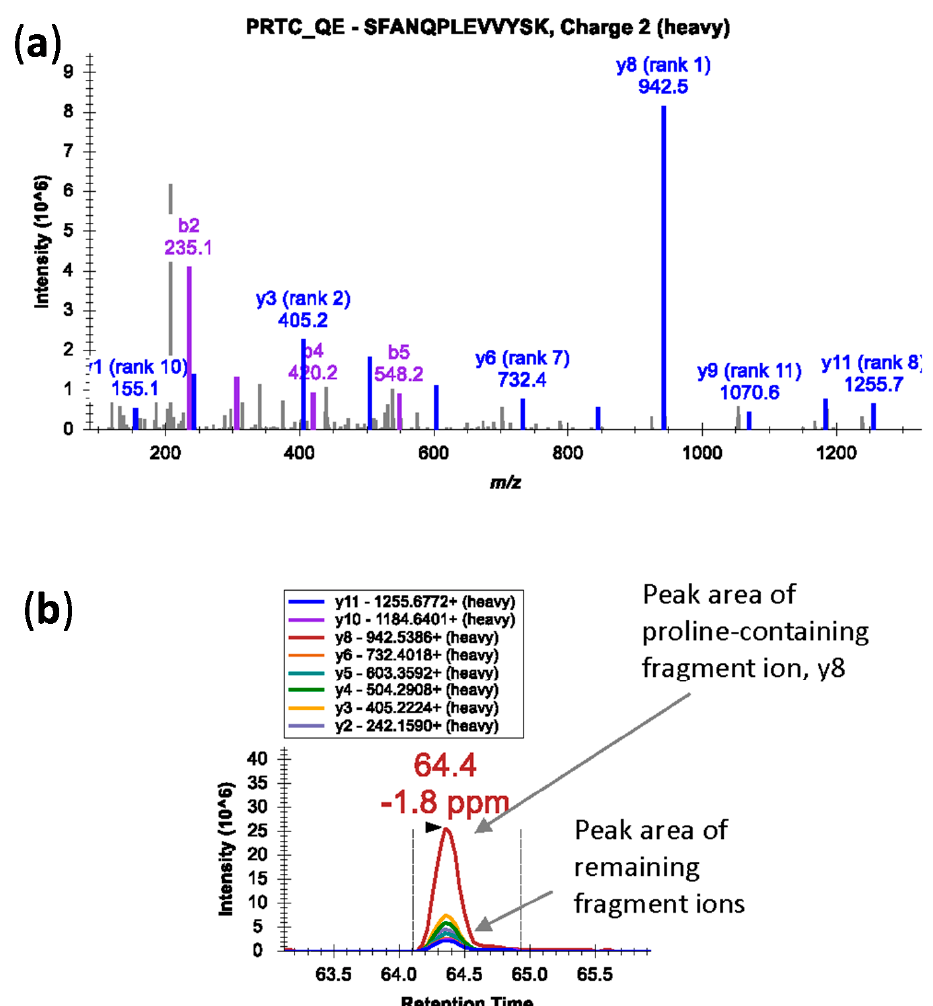
Figure 2. ( a ) An MS/MS spectrum of heavy isotope-labeled peptide SFANQPLEVVYSK* ( m / z 745.3924, 2+) showing dominant y8 fragment ion by cleavage at N-terminal bond of proline residue; ( b ) Peak area contributions of the individual fragment ions of the peptide.